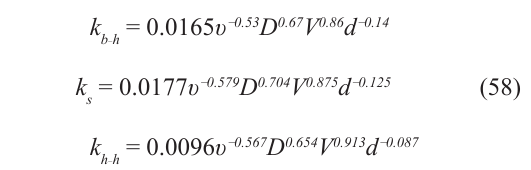
Figure 3. Typical dissolution (corrosion) rates of a film (see equation